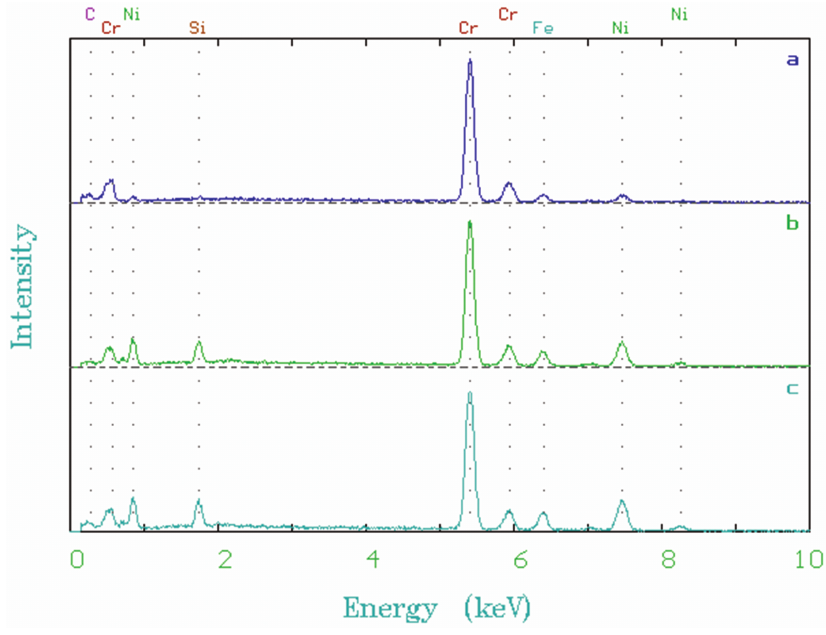
Figure 5: EDX spectra of selected area analyses of the chromium rich carbides in the as-cast (a) and aged for 500 (b) and 1000 h (c).